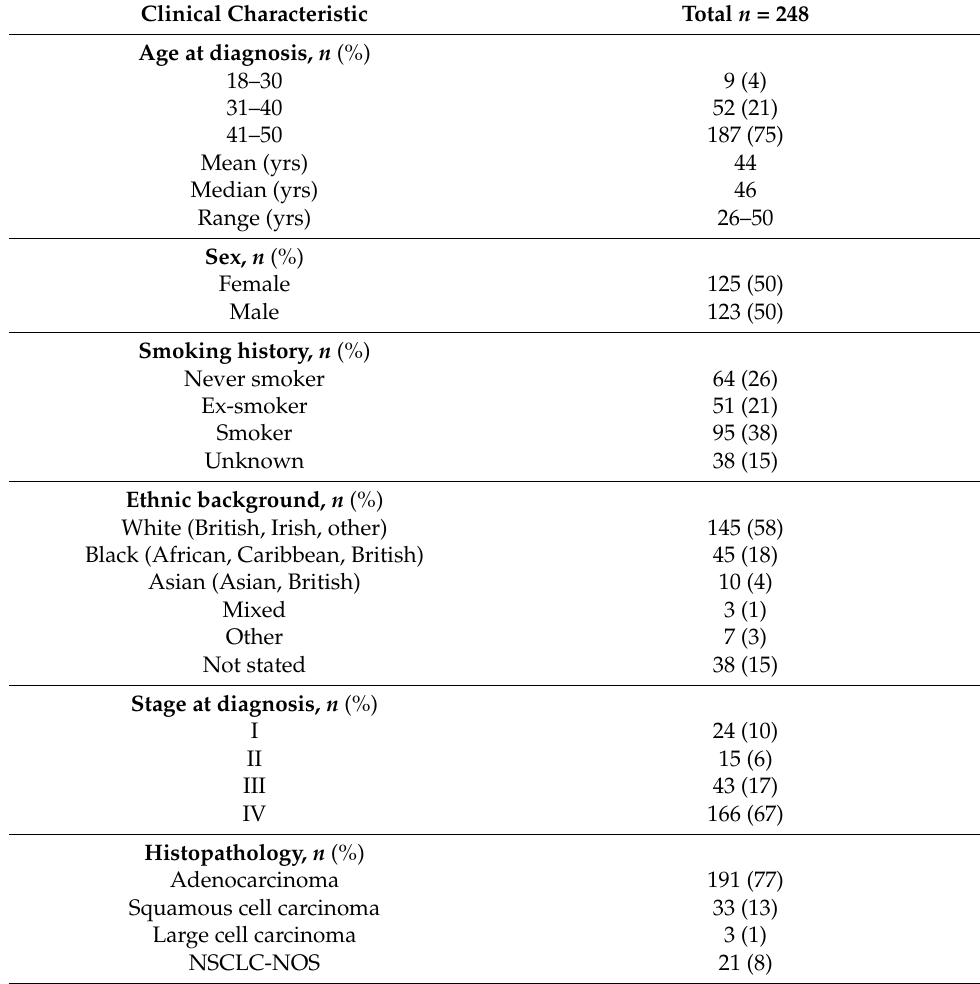
Table 1. Clinical characteristics of all NSCLC patients < 50 years ( n =